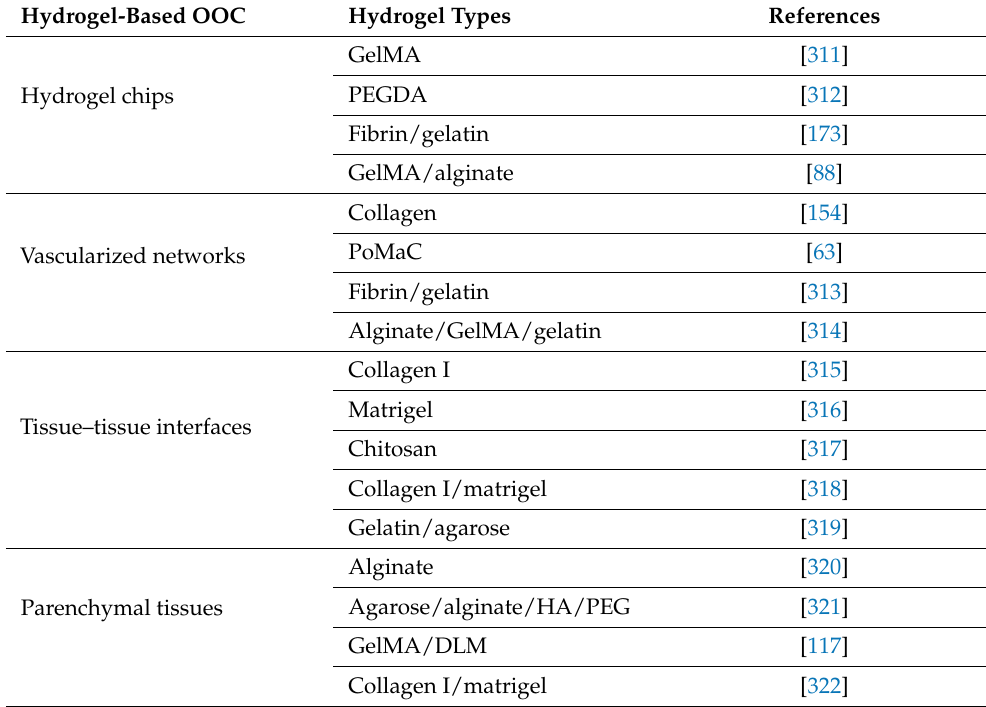
Table 7. Examples of hydrogel-based OOC